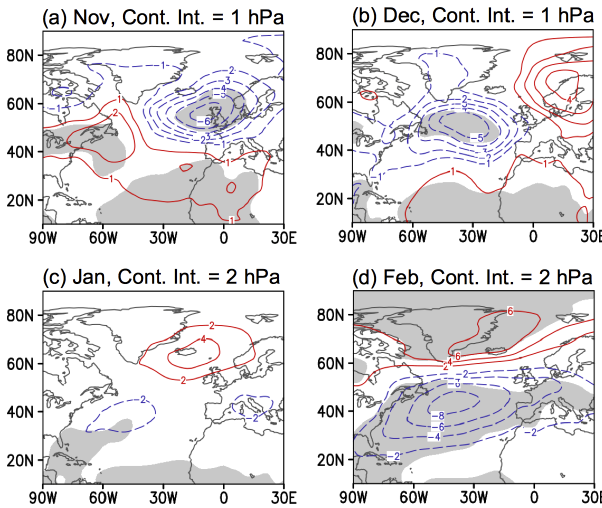
Figure A1. SLP composites for El Niño minus La Niña events dur- ing 1920–2014 for the months shown on the panels. These are sim- ilar to Fig. 1 except here composites for the 4 months are calcu- lated individually. Red (blue) contours indicating positive (negative) anomalies, with gray shading indicating the 5% significance level for a two-tailed t